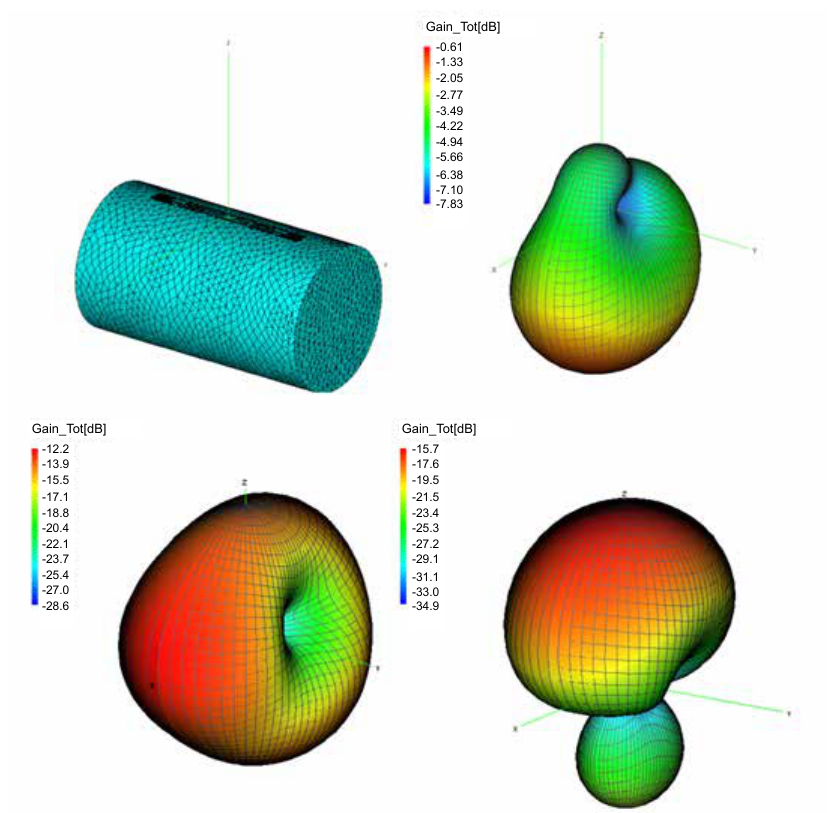
Figure 2. The structure of tag attached to a cylinder and 3D radiation pattern at 920 MHz of tag attached to the cylinder ( upper left ) made of plastic ( upper right ), water ( lower left ) and metal ( lower right